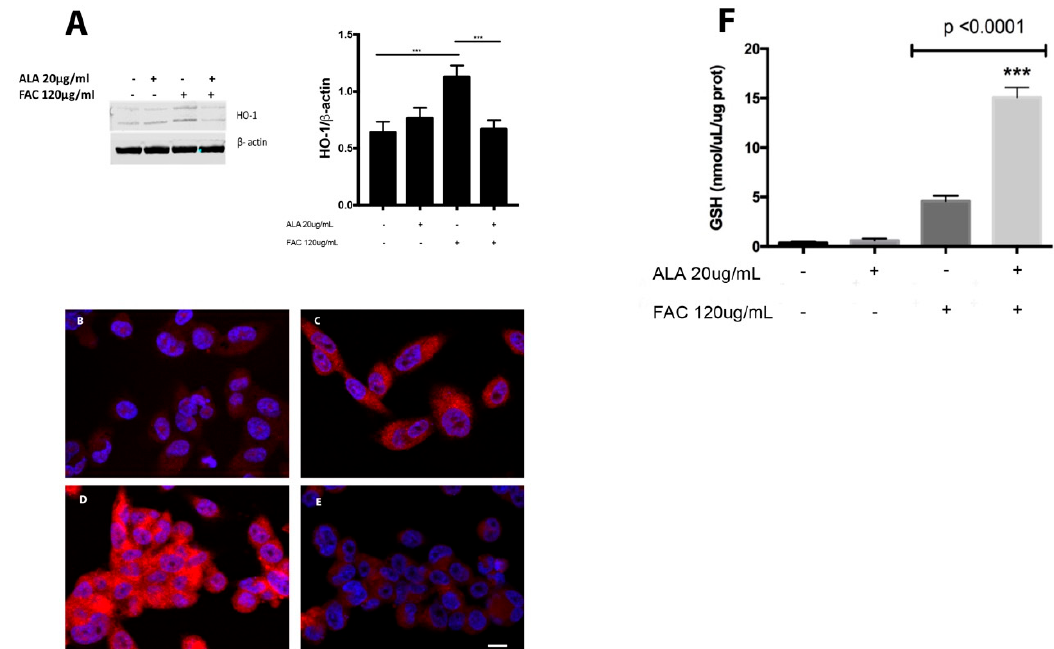
Figure 3. HO-1 protein levels in HS-5 cell cultures treated with FAC (120 µg/mL for 24 h) alone or in combination with ALA (20 µg/mL) were visualized by immunoblotting with specific antibodies ( A ). ß-actin shows an equal amount of protein loading in all lanes. Immunofluorescence showed HO-1 localization in untreated HS-5 cells ( B ) following treatment with FAC (for 24 h) alone ( D ) and with ALA alone or in combination with FAC ( C and E ). All values are presented as mean ± SE of four experiments in duplicate; (*** p < 0.0001) (Scale bars 10 µm).